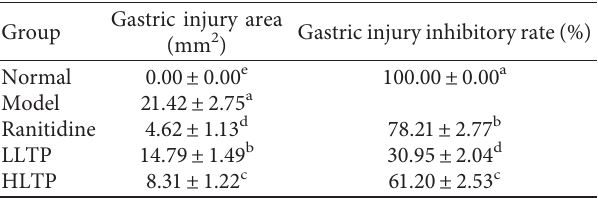
Figure 2: Observation of gastric injury in mice with gastric injury. Ranitidine group: 50mg/kg b.w. ranitidine treatment dose; LLTP group: 100mg/kg b.w. Liupao tea polyphenols dose; and HLTP group: 200mg/kg b.w. Liupao tea polyphenols dose. (a) Normal. (b) Model. (c) Ranitidine. (d) LLTP. (e) HLTP. Table 4: Gastric injury area and inhibition rate of gastric injury in